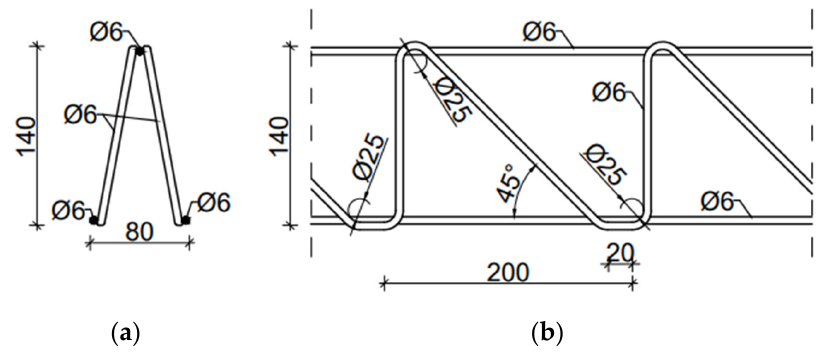
Figure 2. EQ-type spatial truss ( a ) X-X view; ( b ) Y-Y view.